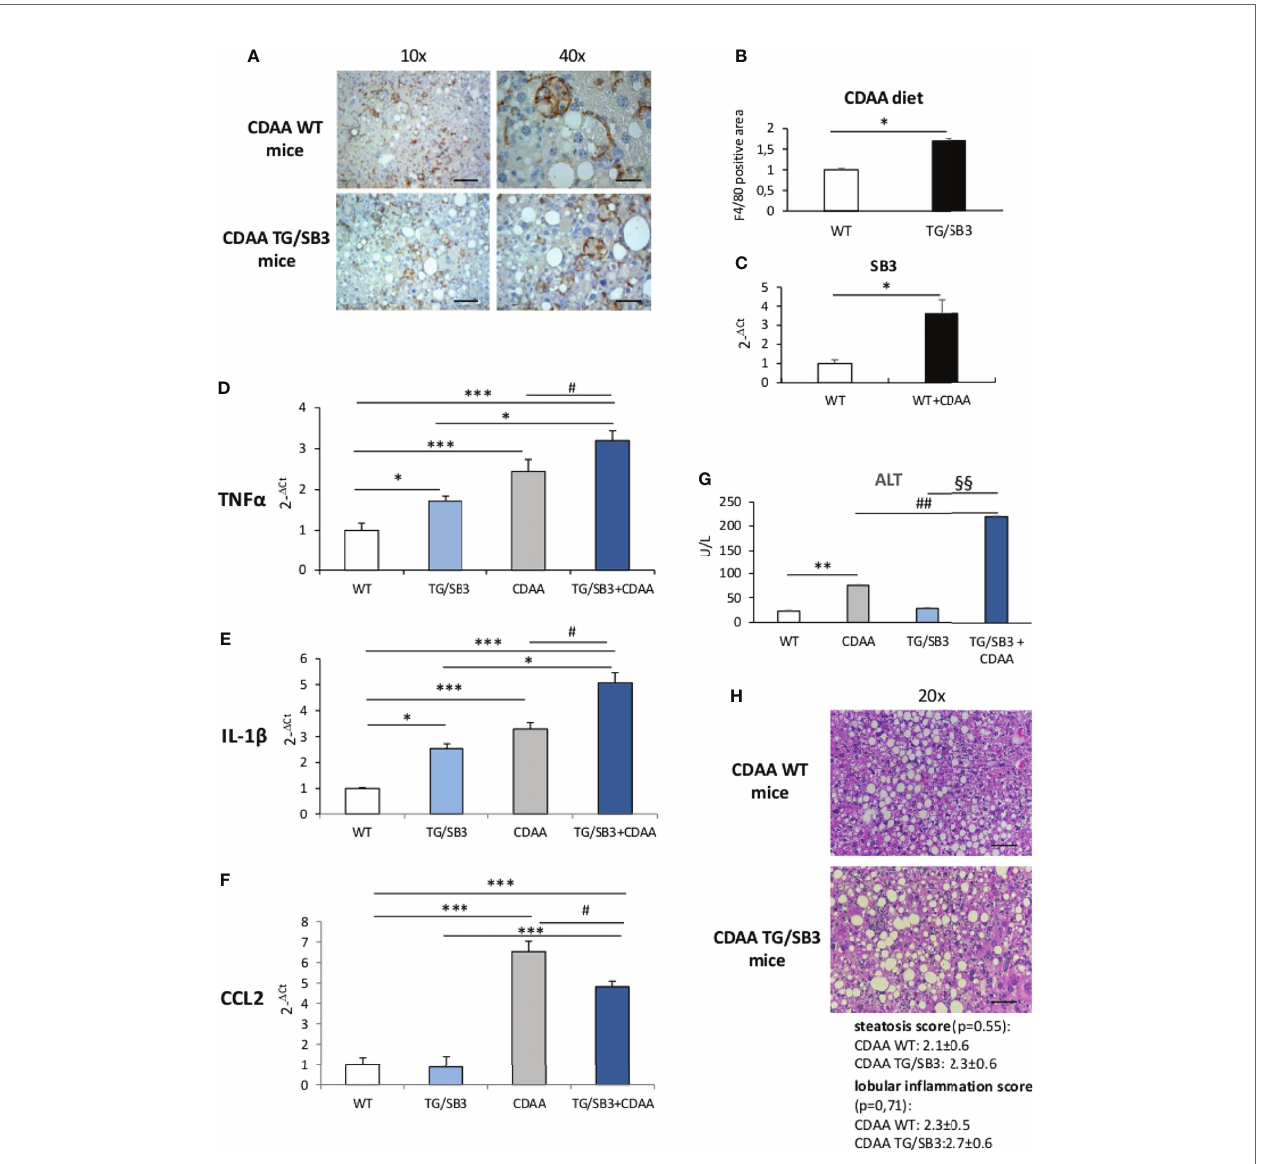
FIGURE 2 | (A – H) (A) Immunohistochemistry analysis for F4/80 on liver specimens obtained from C57Bl6J WT mice and transgenic mice for SB3 (TG/SB3) fed on CDAA for 12 weeks. Magni fi cation 10x, scale bar 200µm, magni fi cation 40x, scale bar 50µm. (B) ImageJ software analysis performed to evaluate the amount of F4/ 80 positive area in C57Bl6J WT mice and transgenic mice for SB3 (TG/SB3) fed on CDAA for 12 weeks. *p < 0.05 versus WT mice. (C) Quantitative real time PCR analysis of SB3 in C57Bl6J WT mice fed on control (WT) or CDAA diet (WT+CDAA). *p < 0.05 versus WT mice. Quantitative real time PCR analysis of TNF a (D) , IL- 1 b (E) and CCL2 (F) in C57Bl6J WT mice and transgenic mice for SB3 (TG/SB3) fed on control CSAA diet (WT and TG/SB3) or CDAA diet for 12 weeks (CDAA and TG/SB3+CDAA). ***p < 0.001 and *p < 0.05 versus WT mice fed on control CSAA diet (WT) or versus TG/SB3 mice fed on CSAA diet; # p < 0.05 versus C57Bl6J WT mice fed on CDAA diet (CDAA). (G) Serum levels of alanine amino transferase (ALT) analyzed as a parameter of parenchymal injury in C57Bl6J WT mice and transgenic mice for SB3 (TG/SB3) fed on control CSAA diet (WT and TG/SB3) or CDAA diet for 12 weeks (CDAA and TG/SB3+CDAA). **p < 0.01 versus WT mice fed on control CSAA diet (WT), ## p < 0.01 versus WT mice fed on CDAA diet, §§ p < 0.01 versus TG/SB3 mice fed on CSAA diet. (H) Hematoxylin eosin staining and score of steatosis and lobular in fl ammation in WT e TG/SB3 mice fed on CDAA diet for 12 weeks to evaluate steatosis and in fl ammation. Magni fi cation 20x,